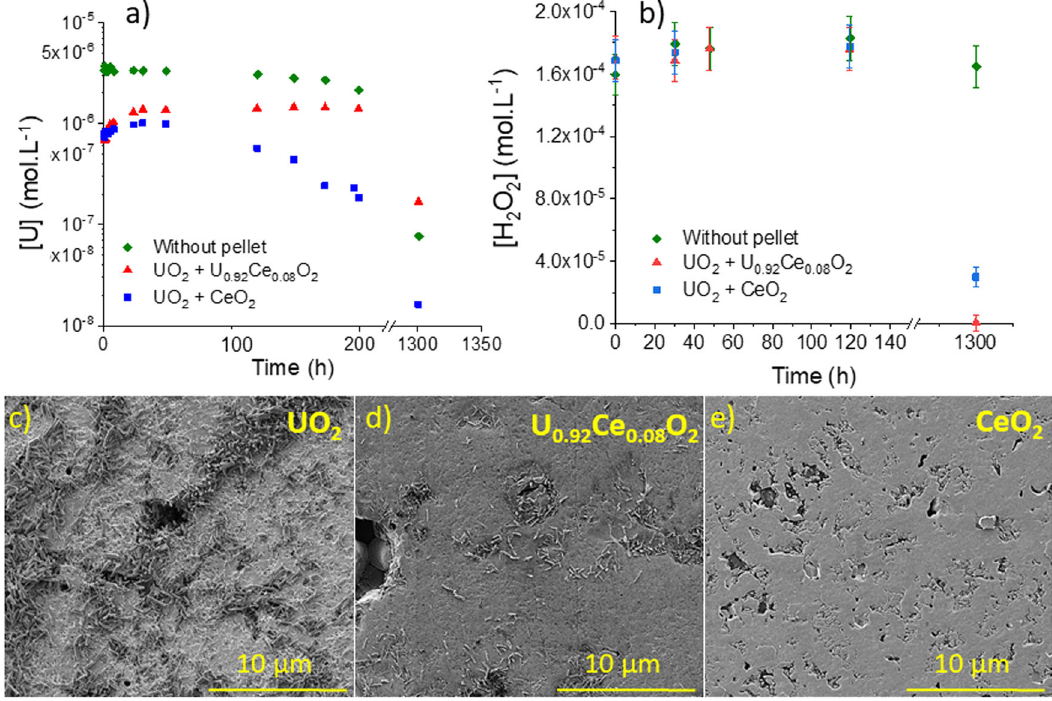
Fig. 11 Evolution of concentrations during static experiments. Evolution of the uranium a and [H 2 O 2 ] b concentrations during static leaching experiments of UO 2 + U 0.92 Ce 0.08 O 2 pellets or UO 2 + CeO 2 pellets in 0.16 mmol.L − 1 HCO 3- solution. SEM micrographs (SE mode) of the surface of the pellets after 1300 h of leaching ( c , d , e ). Error bars are twice the standard